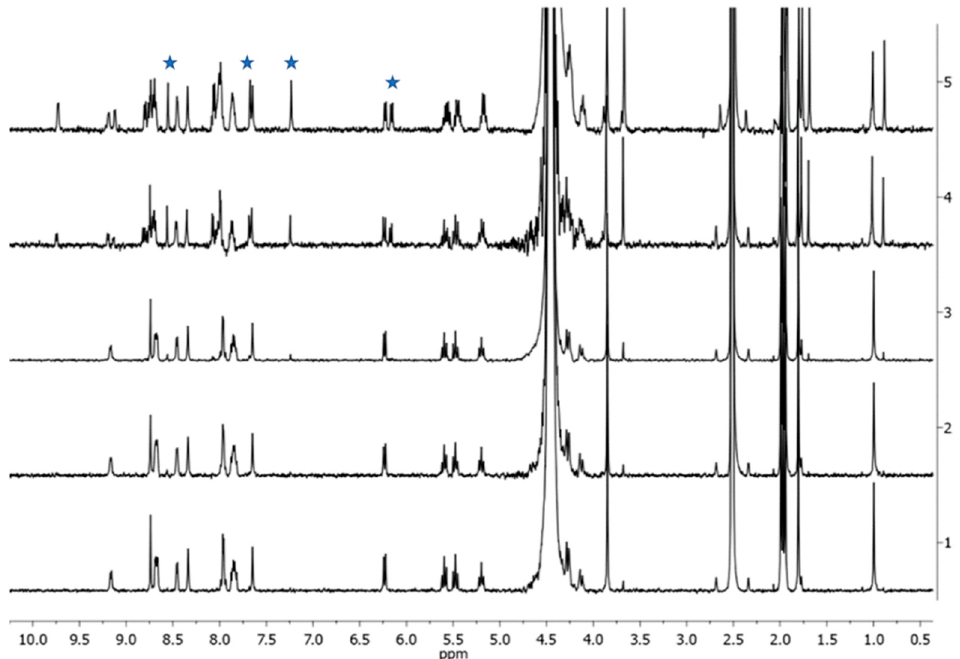
◦ C (trace 1 = start, 2 = 1 h,